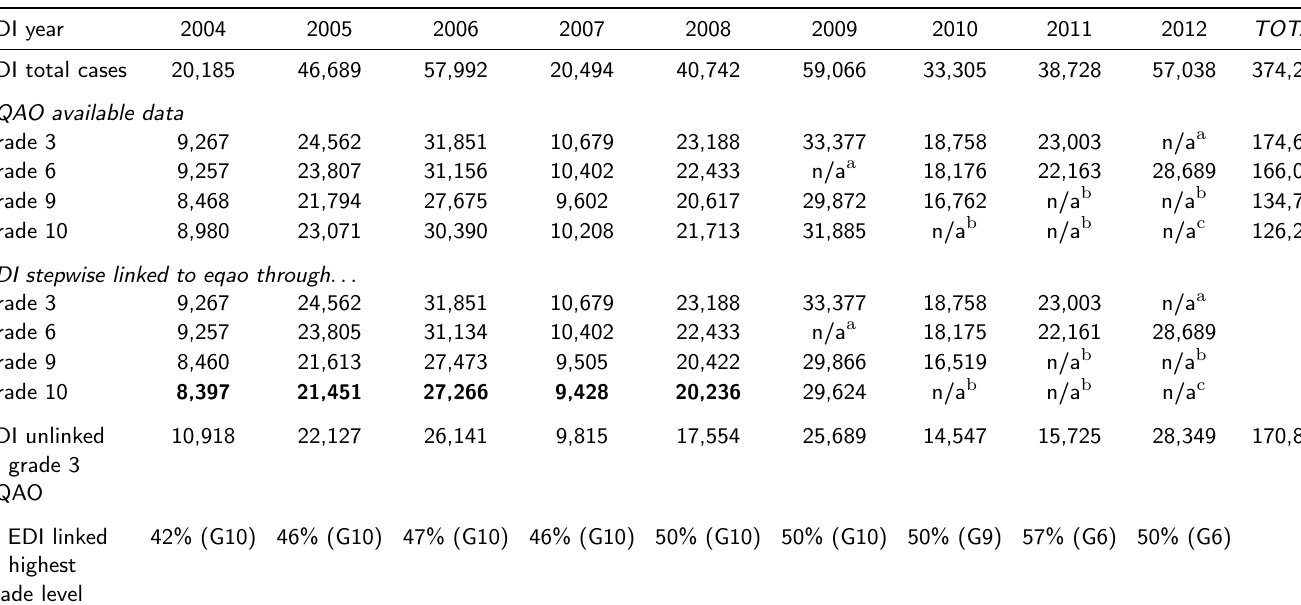
Table 2: Results of EDI and EQAO linkage process